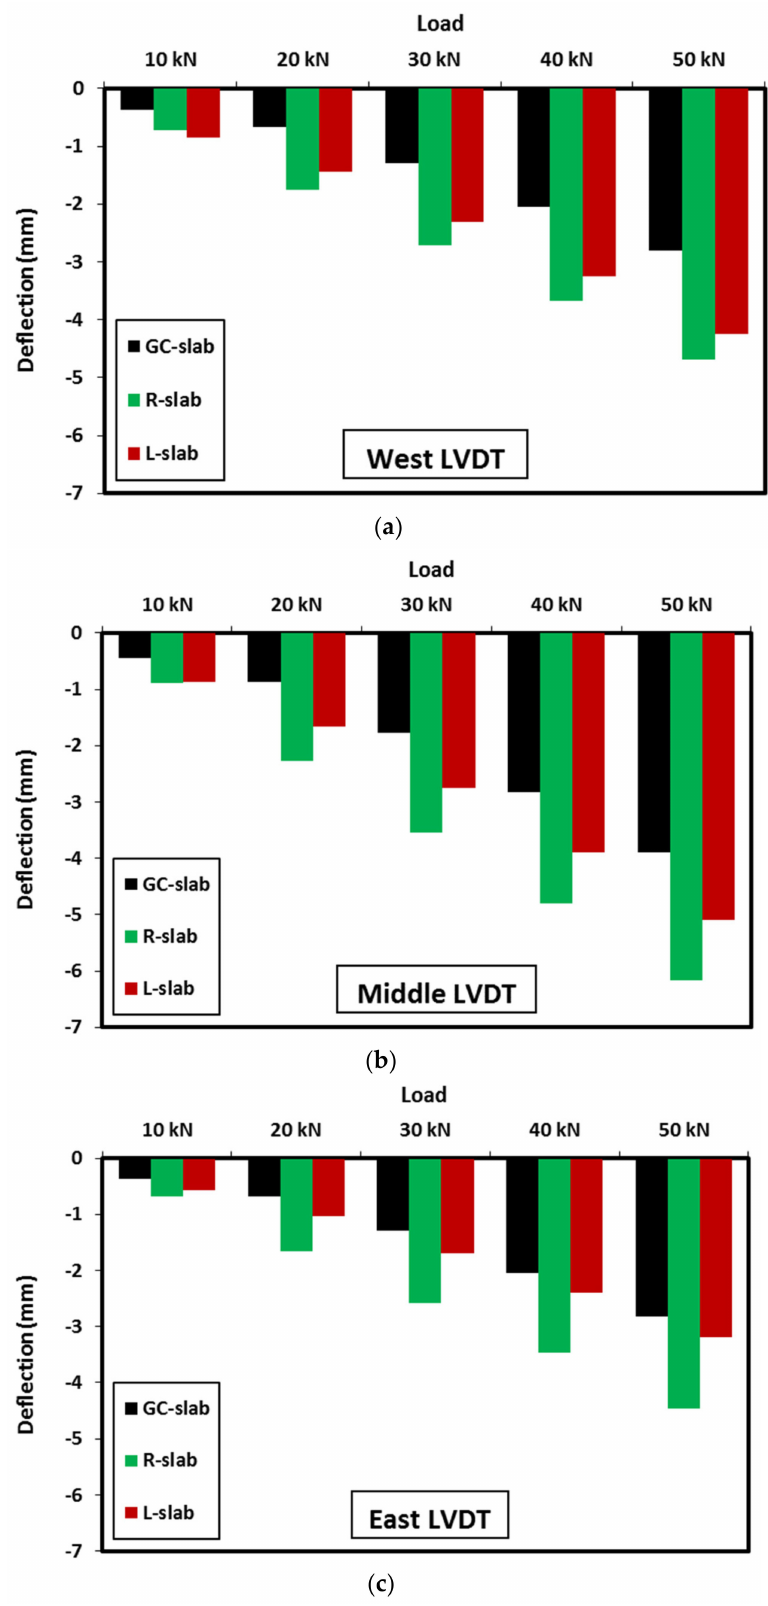
Figure 17. Comparison of slabs deflection at given loads: ( a ) West, ( b ) Middle, and ( c )